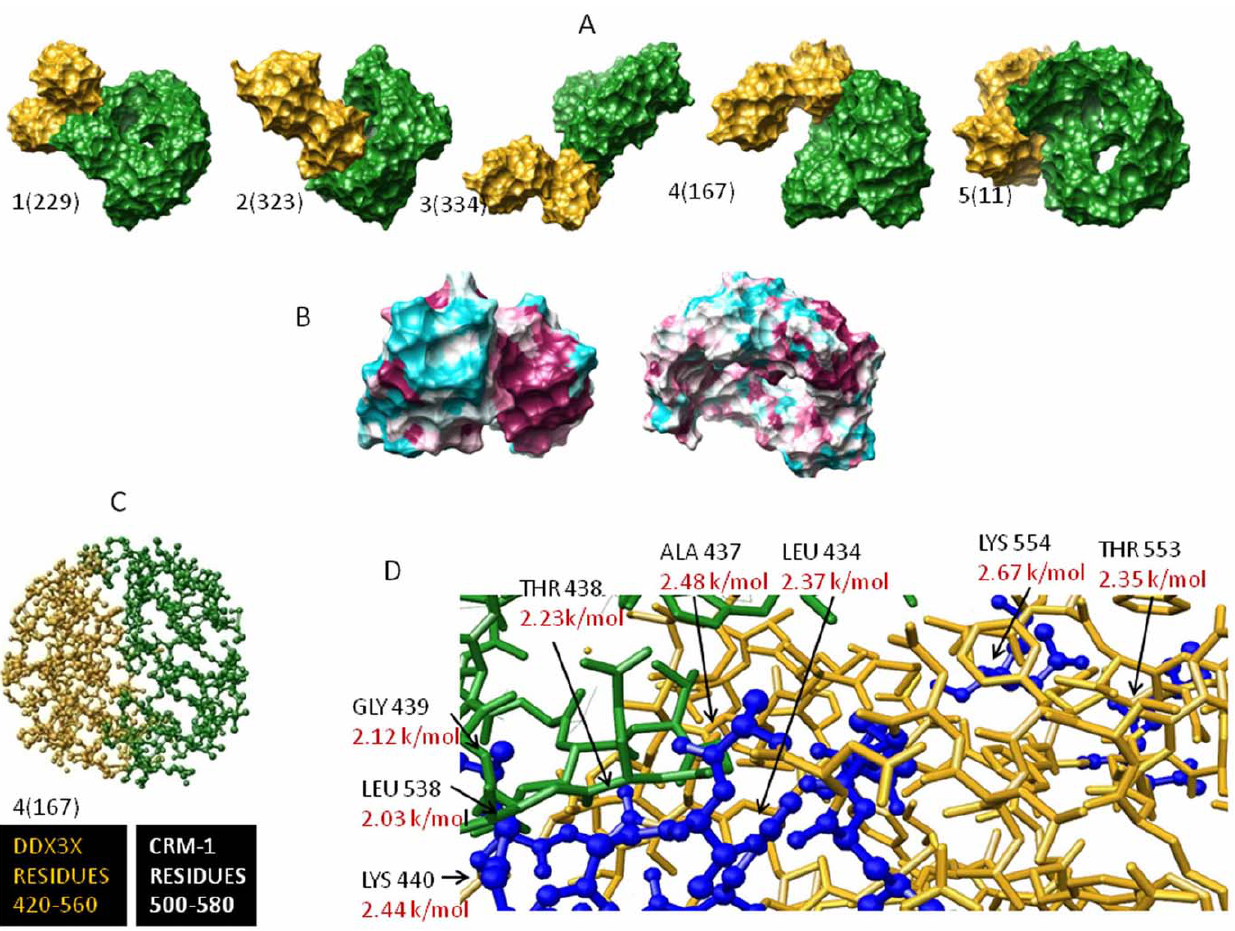
Figure 7. Docking of DDX3X-CRM-1. A) Top 5 docked complexes B) Phylogenetic identification of clusters with binding hot spots. C) Interface of selected complex with identified functional residues. D) Binding energy values are shown in Red.